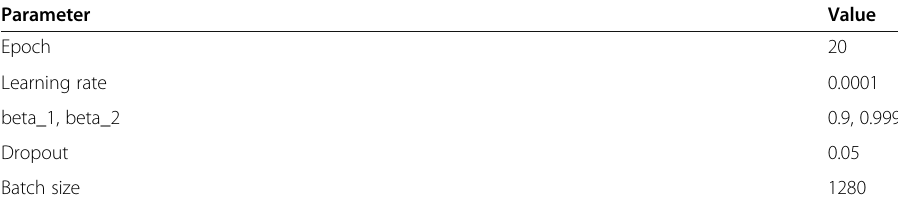
Table 6 Experimental parameters Parameter